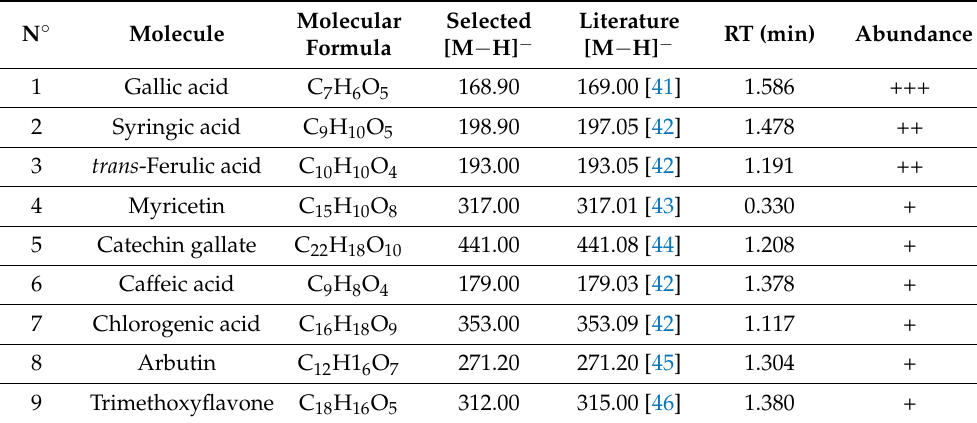
Table 1. Phenolic composition of A. halimus ethanolic extract with LC–MS/MS. N